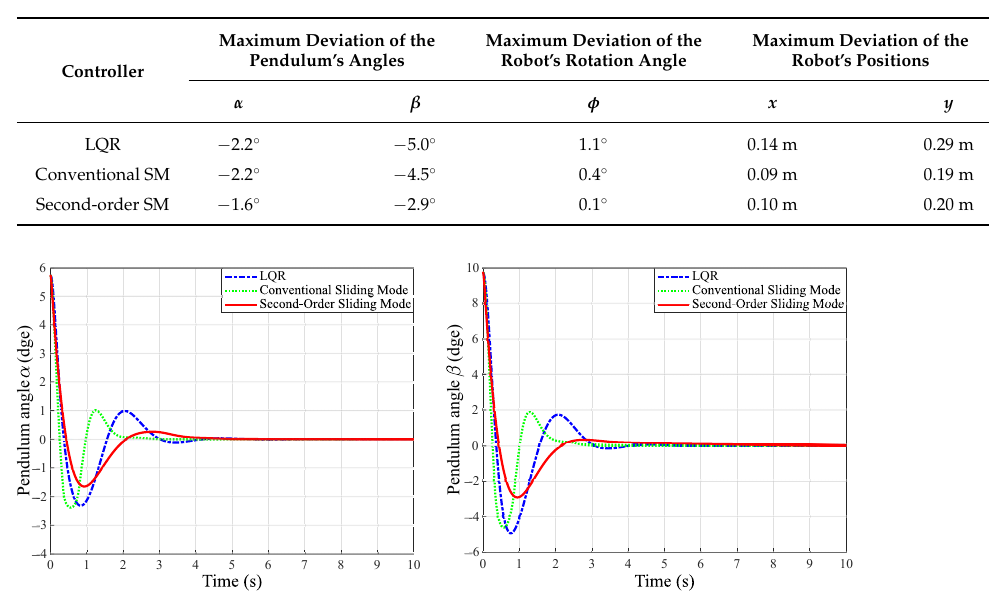
Table 2. The simulation results of the maximum deviations of the pendulum’s angles, the robot’s rotation angle, and the maximum deviations of the robot’s positions.